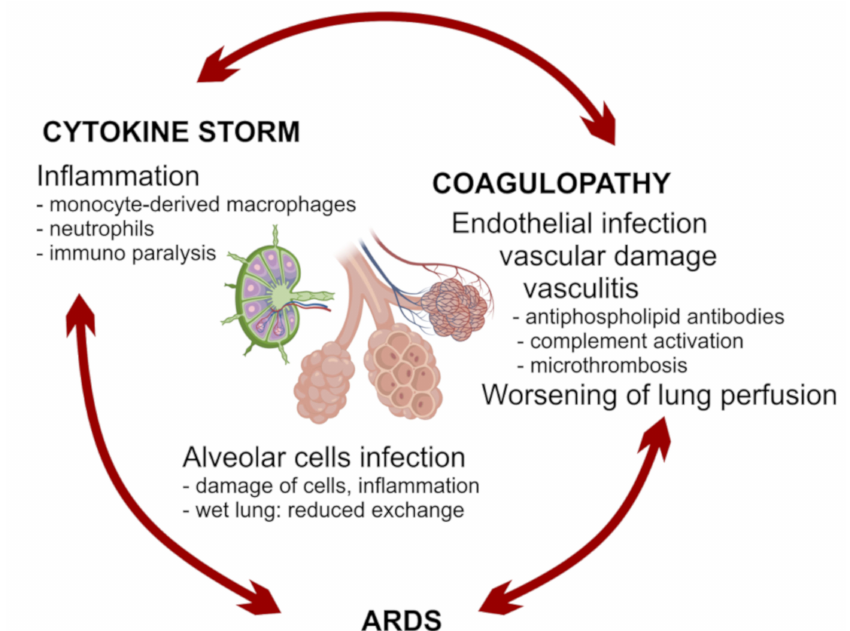
Figure 2. A hypothetical vicious circle between distinct pathogenic mechanisms associated with disease